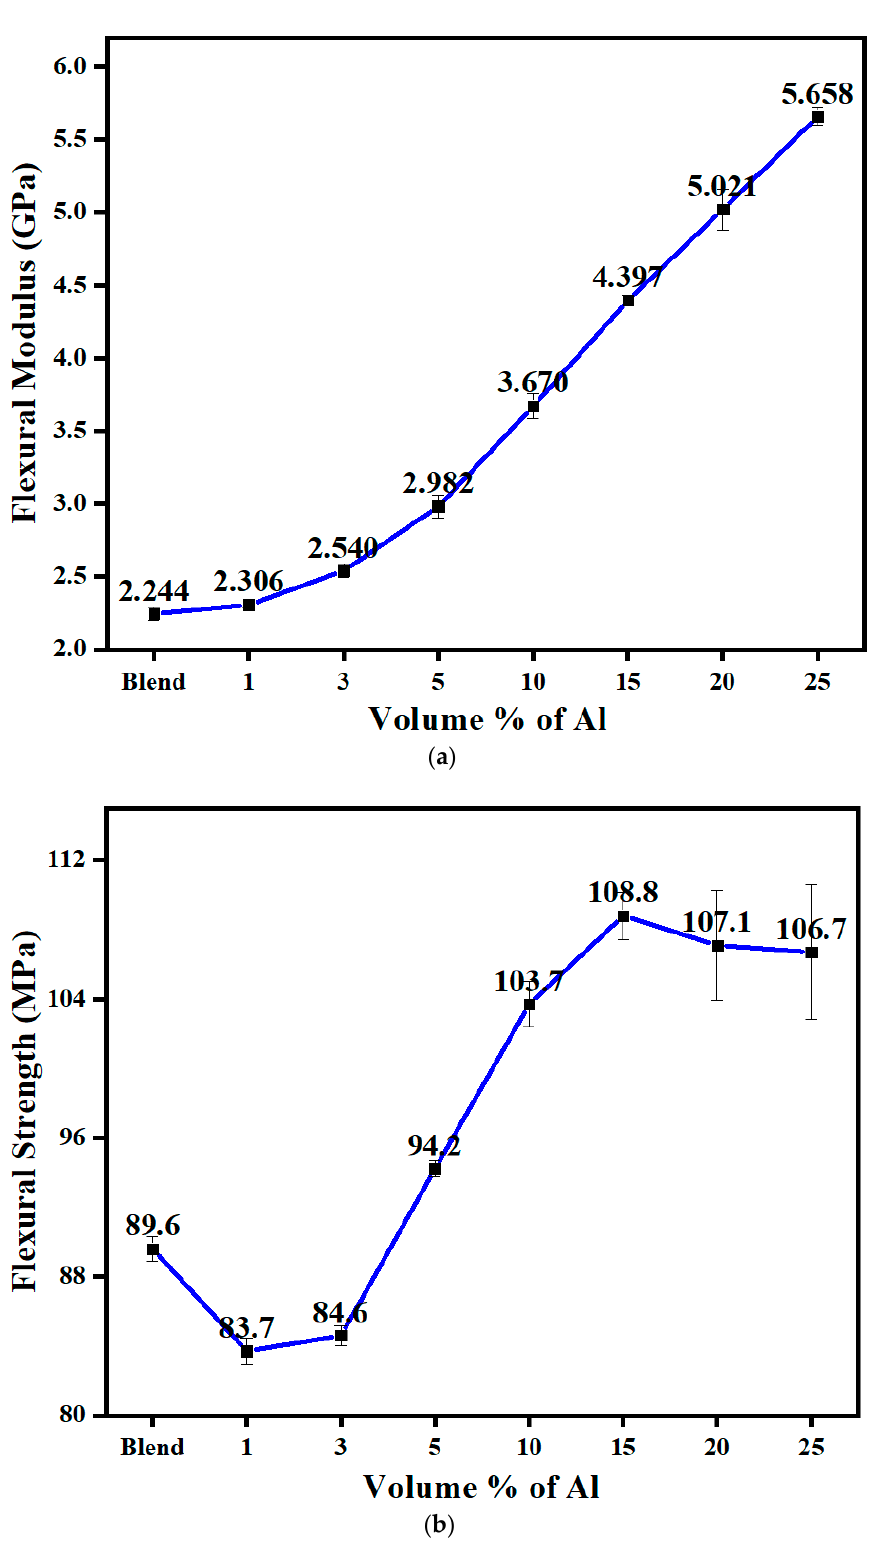
Figure 11. ( a ) Flexural modulus of 60/40 PBT/PET filled with aluminium nano platelets. ( b ) The flexural strength of 60/40 PBT/PET filled with aluminium nano platelets.